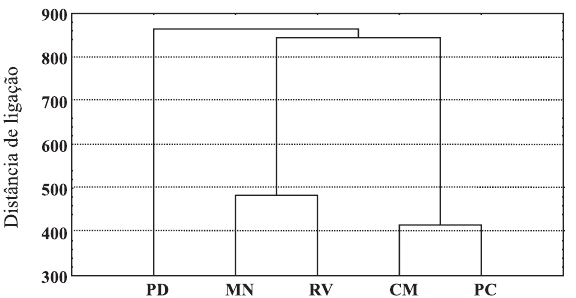
Figura 1. Análise de agrupamento hierárquico do número total de organismos encontrados nas áreas de fumicultura em Plantio Direto (PD), fumicultura em Cultivo Mínimo (CM), fumicultura em Preparo Convencional (PC), Reconversão para Vitivinicultura (RV) e Mata Nativa